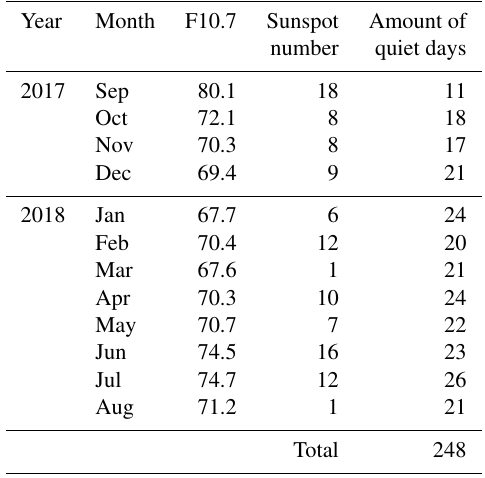
Table 1. The 27d averaged values of F10.7, sunspot number, and the number of quiet-days from September 2017 to August 2018 con- sidered in this